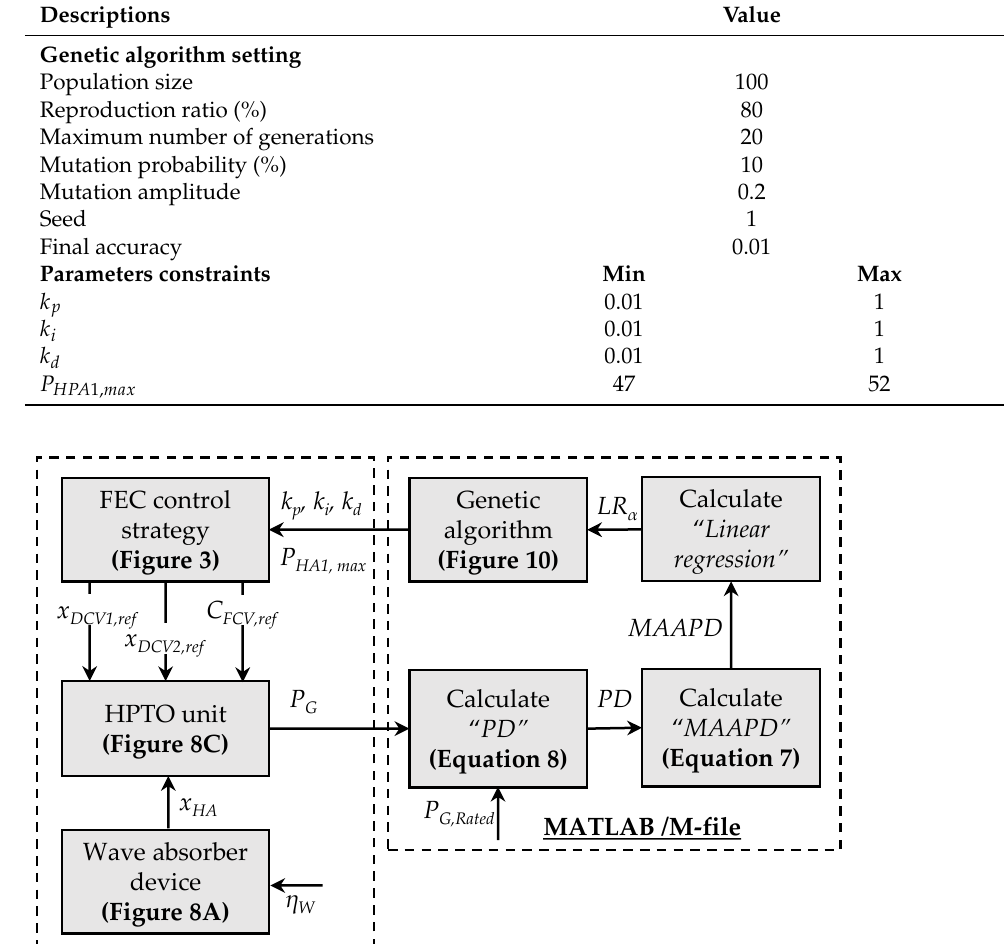
Table 3. Parameters setting of parameters optimization using genetic algorithm.